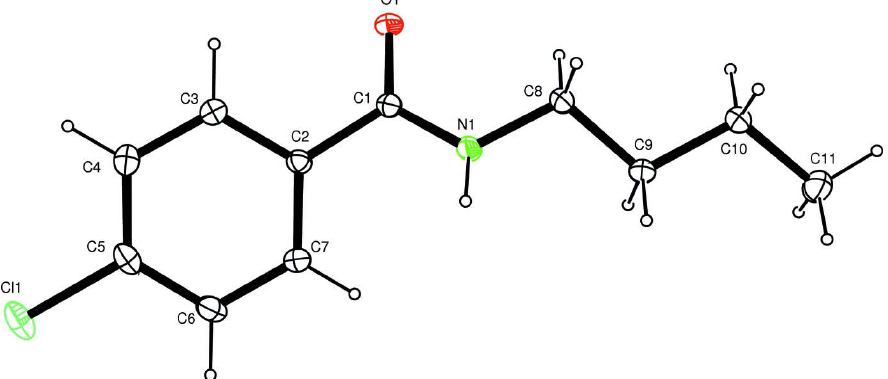
Figure 1 The structure of I showing the atom numbering with displacement ellipsoids drawn at the 50% probability level.